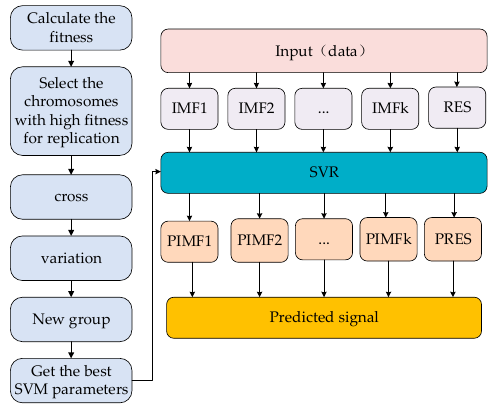
Figure 3. The flow chart of EMD-SVR. IMF: intrinsic mode functions; SVR: support vector regression; PIMF: predicted intrinsic mode functions.